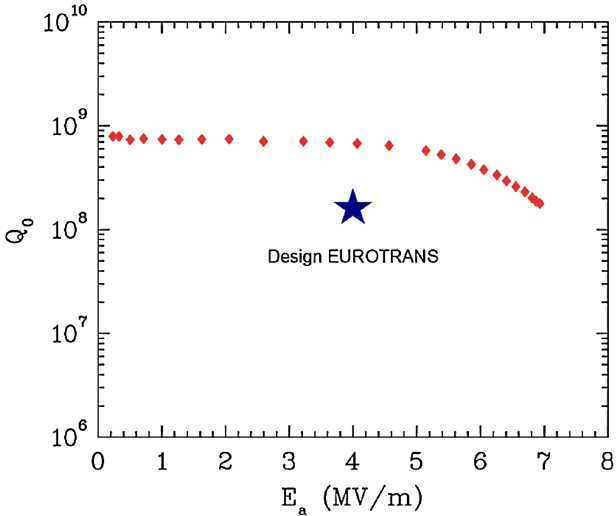
FIG. 8. (Color) Unloaded Q value (measured at 4.4 K) of the 0 SC CH-prototype cavity as a function of the accelerating gra- dient E a and the choice of E a for the EUROTRANS SC CH cavities [18]. FIG. 9. (Color) Main dynamics parameters along the